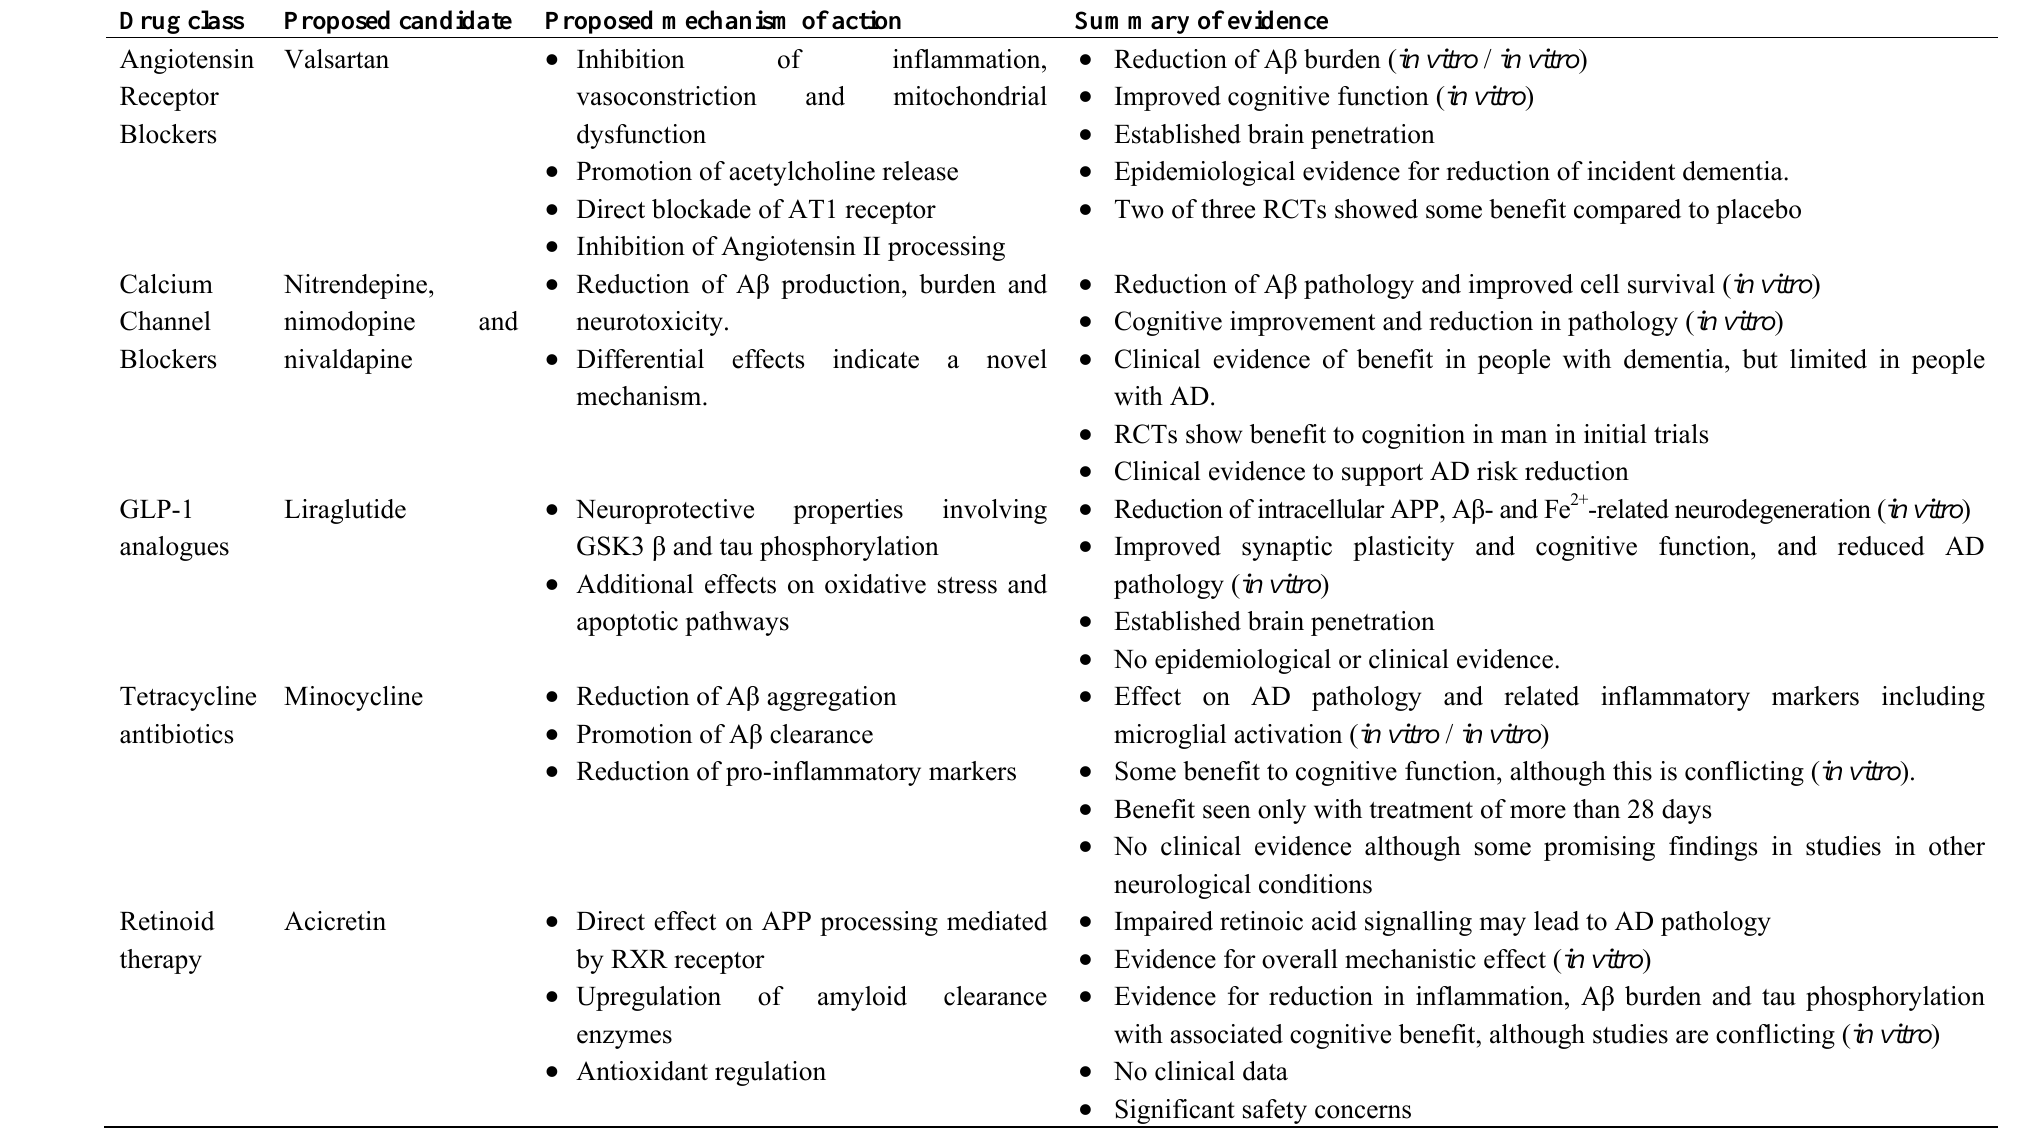
Table 1. Priority candidate drugs for repositioning in AD (adapted from Corbett et al. 2012